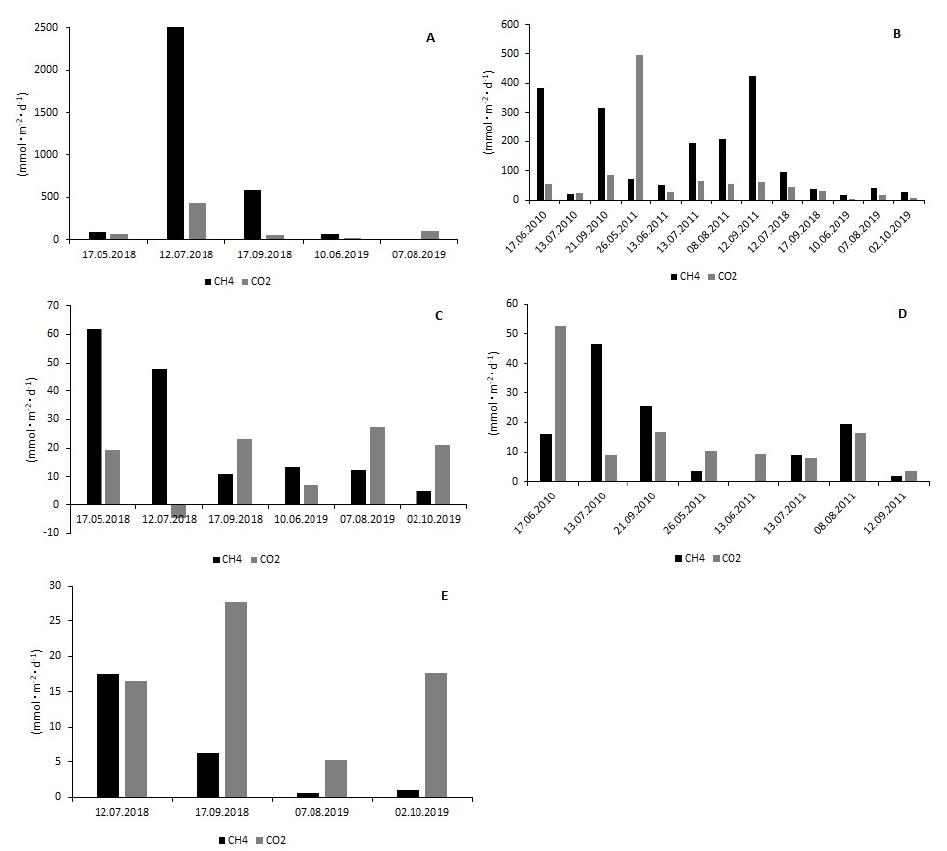
Figure 5. Time series of CH 4 and CO 2 fluxes at the water–air interface in Nielisz Reservoir (panel A—station N1, panel B—N2, panel C—N3, panel D—N4 and panel E—N5).